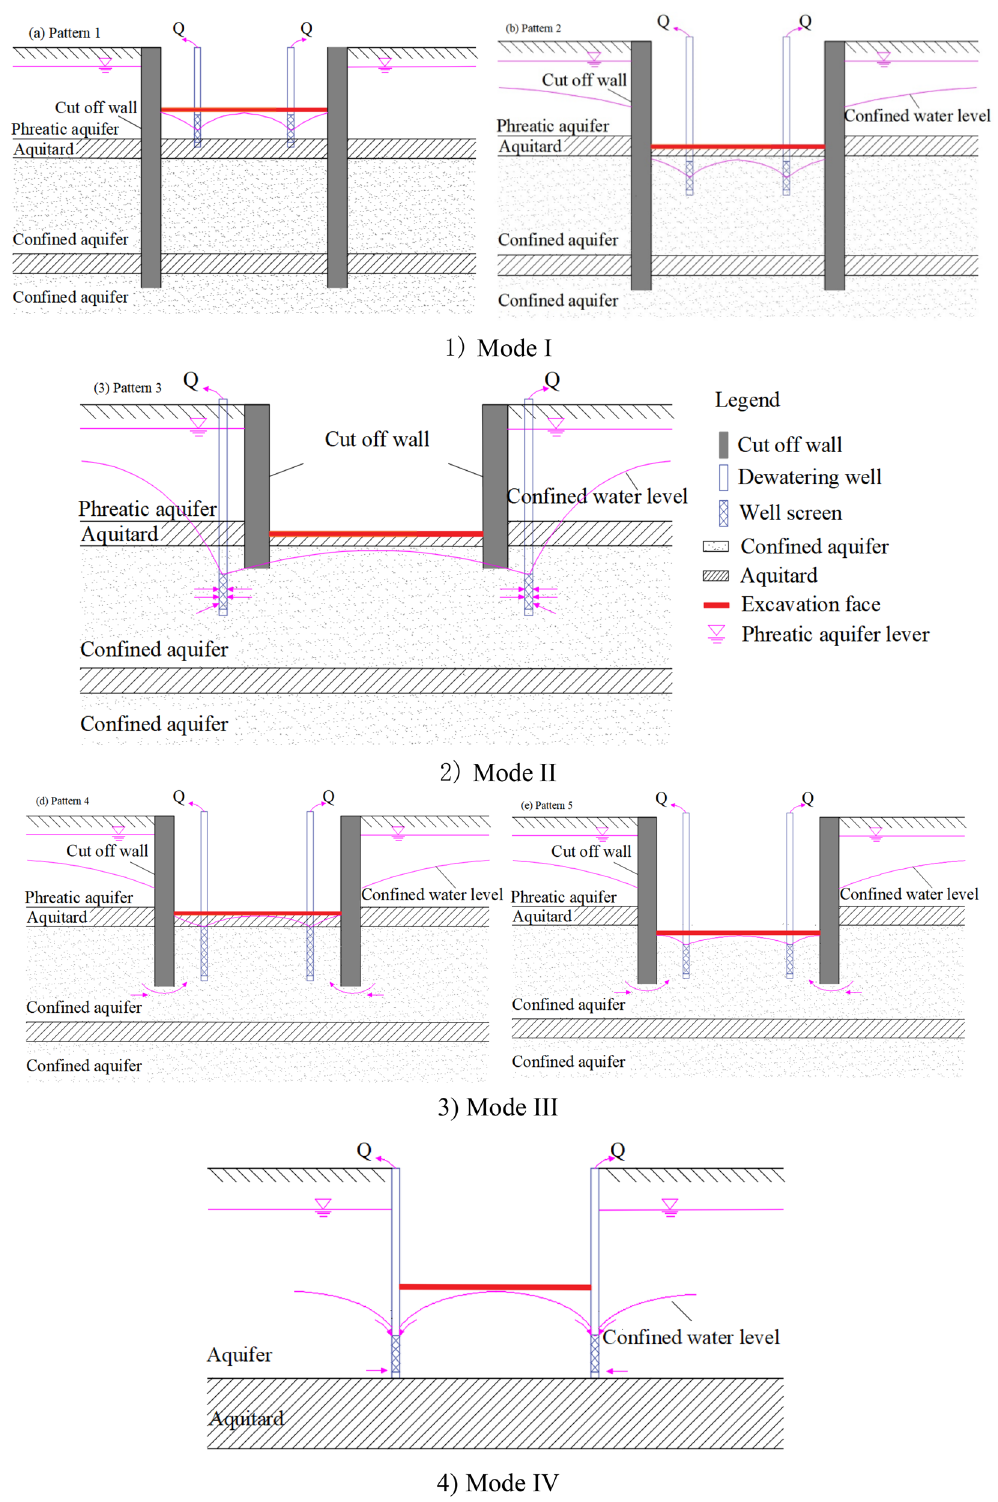
Figure 15. Conceptual model of four summarized seepage